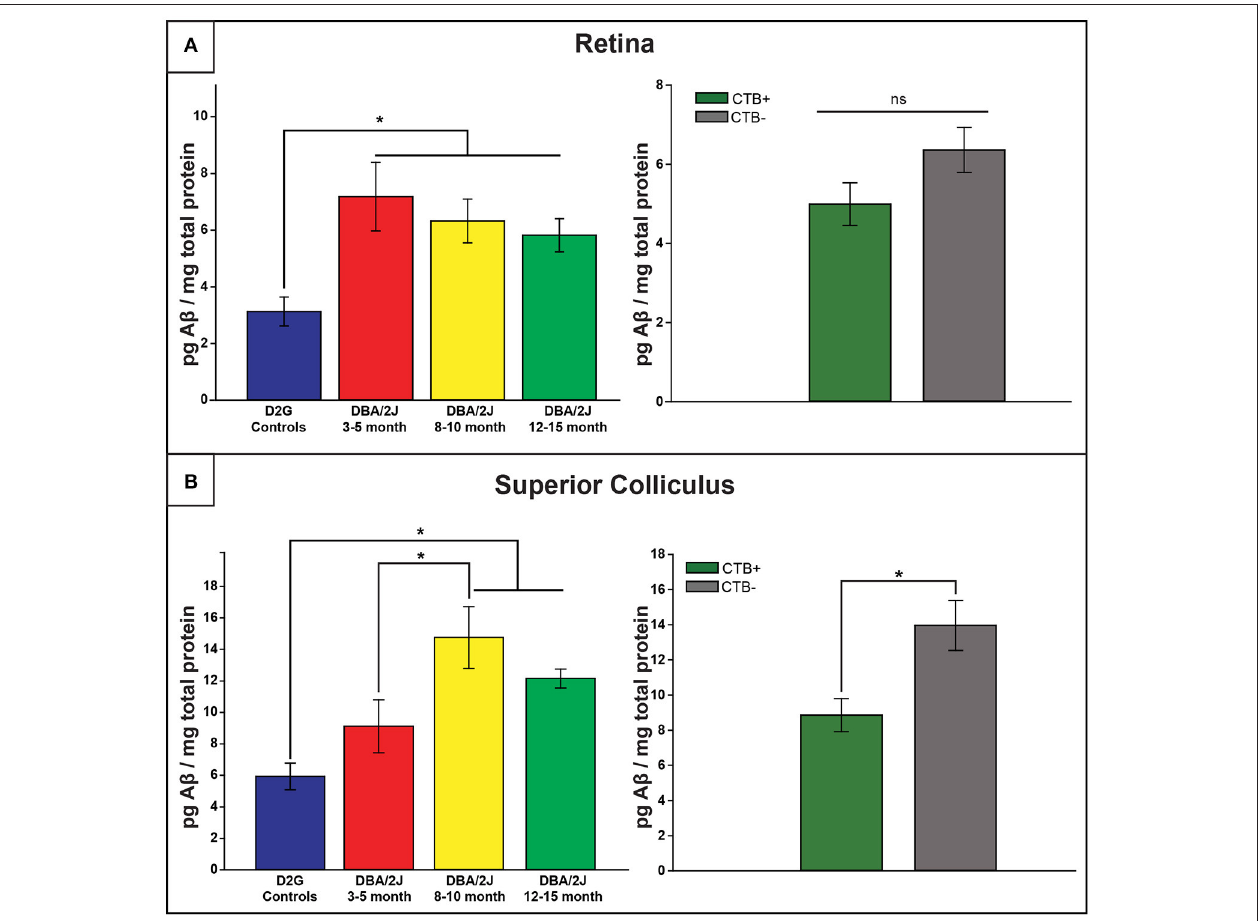
FIGURE 5 | Amyloid- β 42 elevations provide an early retinal marker of pathology and are later observed in the distal projection. (A) Retinal A β 42 was elevated in all DBA/2J age groups compared to controls (left), with no transport-dependent effects observed (right). (B) However, collicular elevations appeared later, with 8–10 and 12–15 month DBA/2J SC having significantly elevated levels compared to controls; a significant difference was also observed between 3–5 and 8–10 month DBA/2Js (left). Levels of A β 42 were significantly elevated in SC lacking intact transport (CTB-) compared to transport-intact (CTB + ) SC (right). Error bars indicate SEM. Asterisk indicates that groups are significantly different from bracketed comparison ( p <